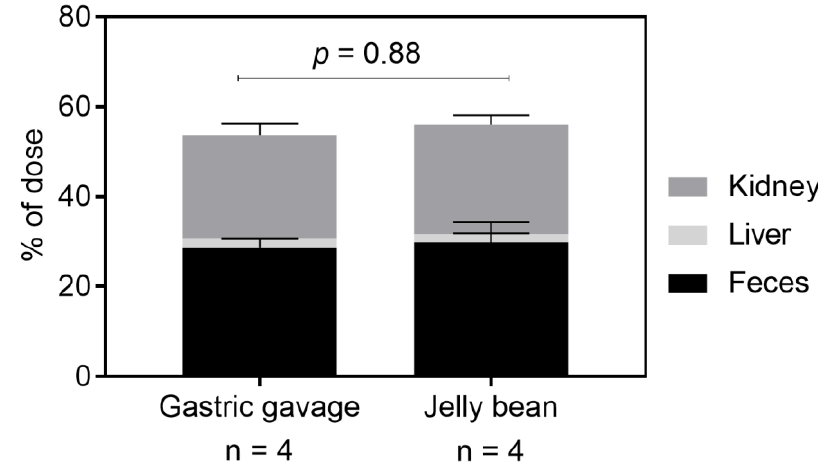
Figure A1. Result of the pilot study. [ 57 Co]CN-B12 accumulation 24 hours after oral administration. Kidney, liver, and feces were collected from two groups of rats ( n = 4 in each group) kept for two weeks on a low-B12 diet before given a single oral dose of radiolabeled [ 57 Co]CN-B12 by either gastric gavage or in a jelly bean. Results are given as the percentage of cpm of the given dose of [ 57 Co]CN- B12. Stacked mean values with SEM are shown. No differences were observed in kidneys ( p = 0.69), liver ( p = 0.34), or feces ( p = 0.69) between the two groups, or in the sum of cpm measured ( p = 0.88). The Mann Whitney test was used to compare the two groups, and p - values ≤ 0.05 were considered statistical significant.